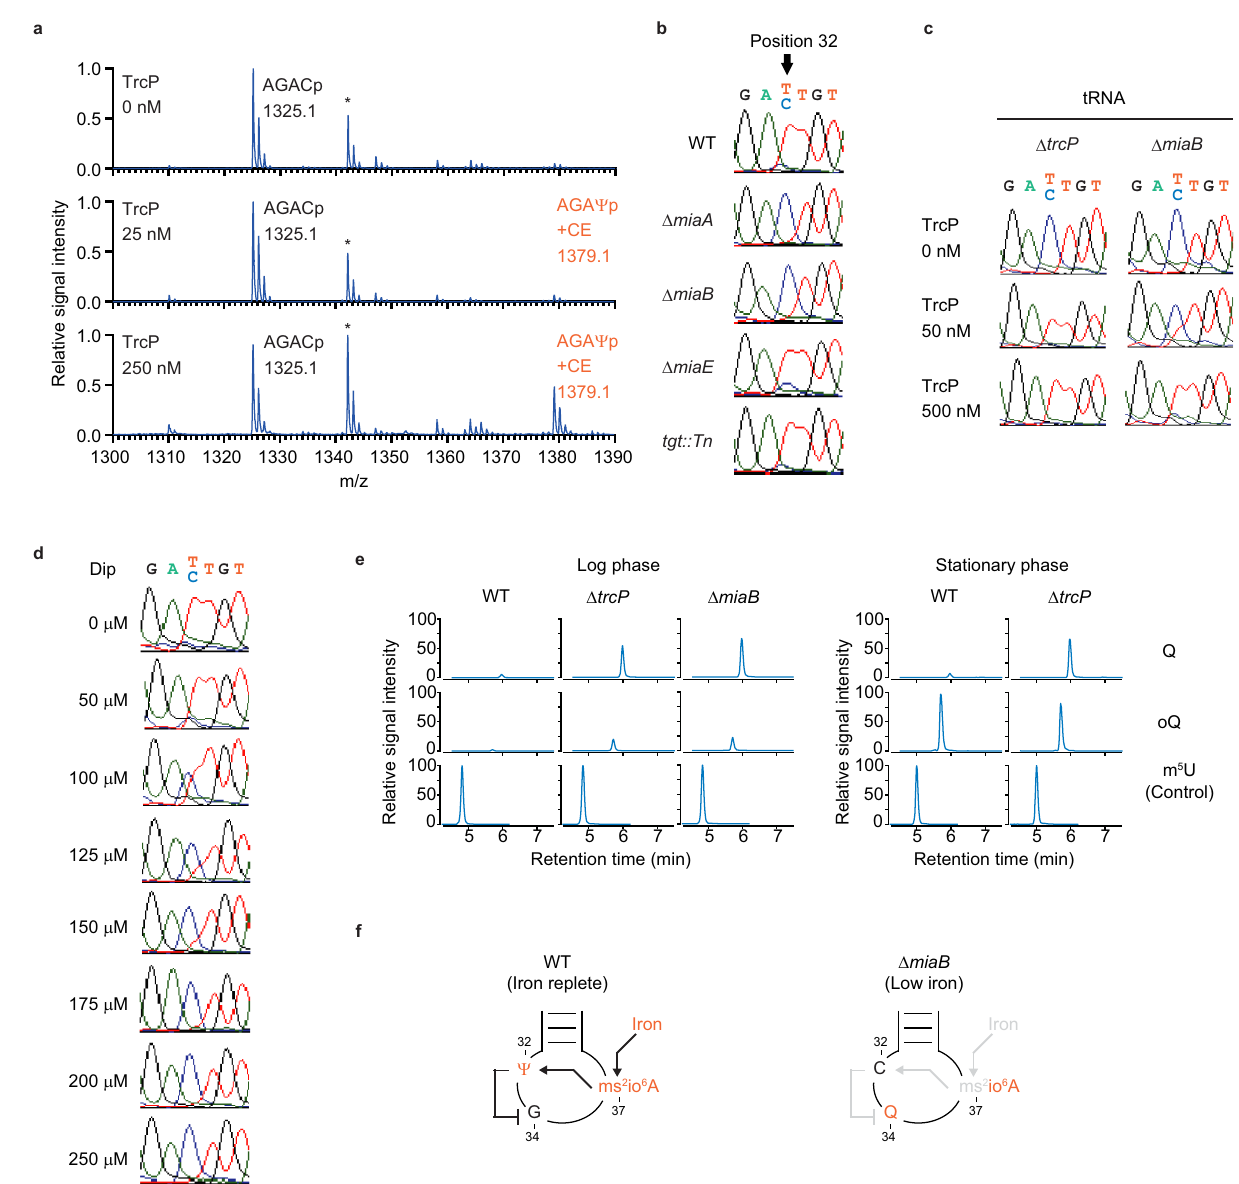
Fig. 5 | An iron-responsive modi fi cation network in V. cholerae tRNA-Tyr. a MALDI-TOF analysis of the oligo-protected portion (positions 10 – 46) of in vitro transcribedtRNA-Tyr.tRNA(250nM)wasreactedwith0nM(top),25nM(middle), and 250nM (bottom) recombinant TrcP. Oligo-protected portions were incubated withacrylonitrile, whichspeci fi callycyanoethylates(CE)pseudouridine,increasing itsmassby53Da.m/zvaluesandassignedfragmentsequencesareshown.Asterisks indicate the fragment corresponding to the tetramerfragment, GAGDp (m/z 1344) derived from positions 13 – 16. b Sanger sequence of tRNA-Tyr cDNA from RNA isolated from WT (Top), Δ miaA (second top), Δ miaB (middle), Δ miaE (second bottom), and tgt :: Tn (bottom) strains. c Sanger sequence of cDNA of tRNA-Tyr isolated from a Δ trcP strain (left) or a Δ miaB strain (right). tRNAs (250 nM) were incubated with 0nM, 50nM, and 500nM TrcP. d Sanger sequence of tRNA-Tyr